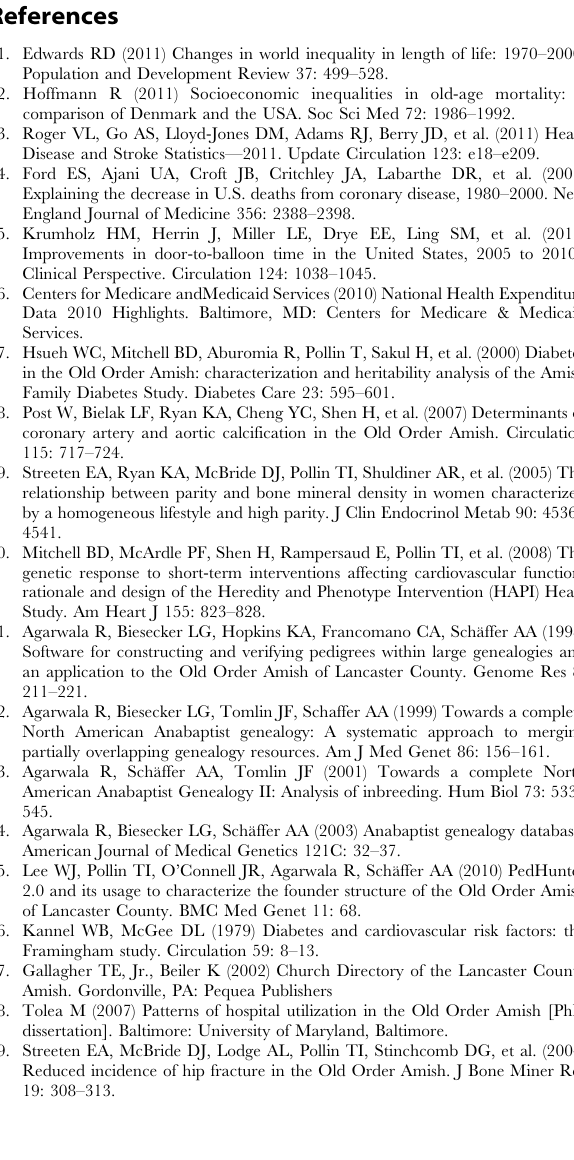
Table S3 Three-year rates of first-listed hospital dis- charges (per 10,000), Caucasians from the NHDS, 2002– 2004. Table S4 Three-year rates of any-listed hospital dis- charges (per 10,000) among Old Order Amish residing in Lancaster County, Pennsylvania, 2002–2004. Table S5 Three-year rates of any-listed hospital dis- charges (per 10,000), Caucasians from the NHDS, 2002– 2004. Table S6 Standardized ratios* comparing hospital discharge rates for any-listed diagnostic procedures